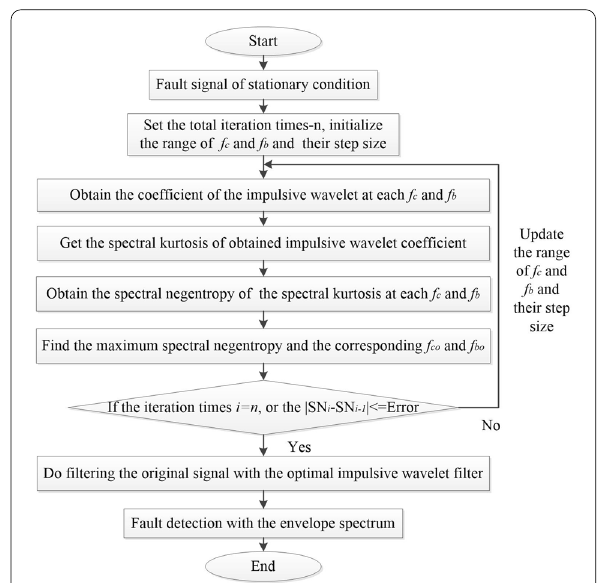
Figure 1 Flowchart of the proposed